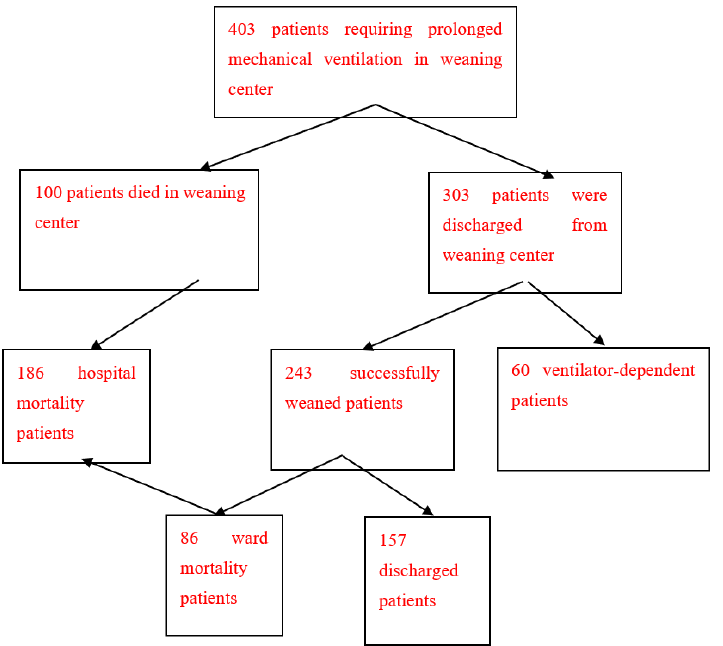
Figure 1. Clinical outcomes of 403 patients requiring prolonged mechanical ventilation. 1. The long-term follow-up data of 403 prolonged mechanical ventilation patients included 100 respiratory care center mortality prolonged mechanical ventilation patients and 303 patients discharged from respiratory care center. 2. Among the 303 patients discharged from the respiratory care center, 243 were successfully weaned from prolonged mechanical ventilation and 60 were ventilator-dependent. 3. One hundred and eighty-six patients who died in the hospital after prolonged mechanical ventilation included 100 patients who died in the respiratory care center and 86 successfully weaned patients who died in the ward. 4. Two hundred and forty-three prolonged mechanical ventilation patients were successfully weaned, including 157 discharged prolonged mechanical ventilation patients and 86 ward mortality prolonged mechanical ventilation patients.